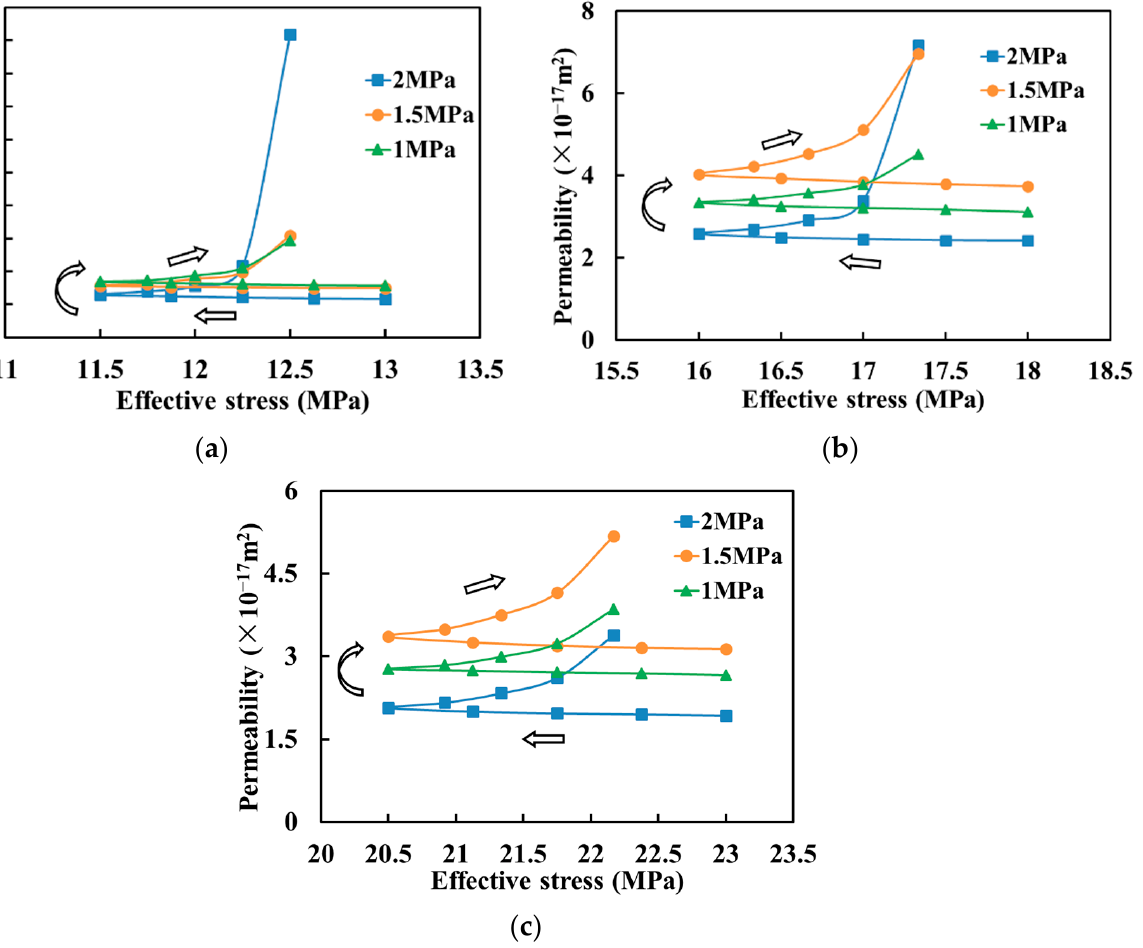
Figure 11. Permeability variation of sandstone under different effective stresses (( a – c ) are the initial confining pressure of 15 MPa, 20 MPa, and 25 MPa, respectively).